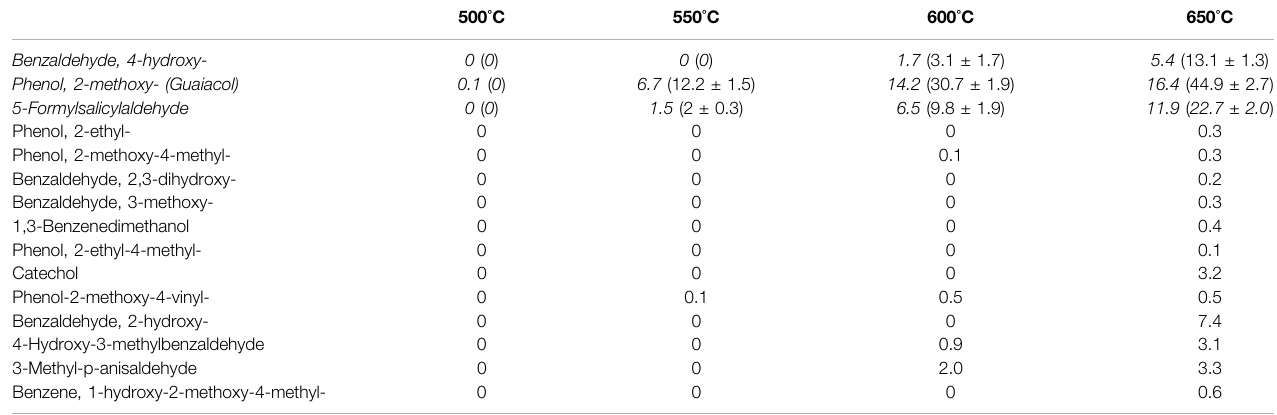
TABLE 1 | List of phenolic compounds obtained from fast pyrolysis of vanillin at different temperatures, and their composition (in peak area%). The wt% yields of major species are shown in parenthesis.